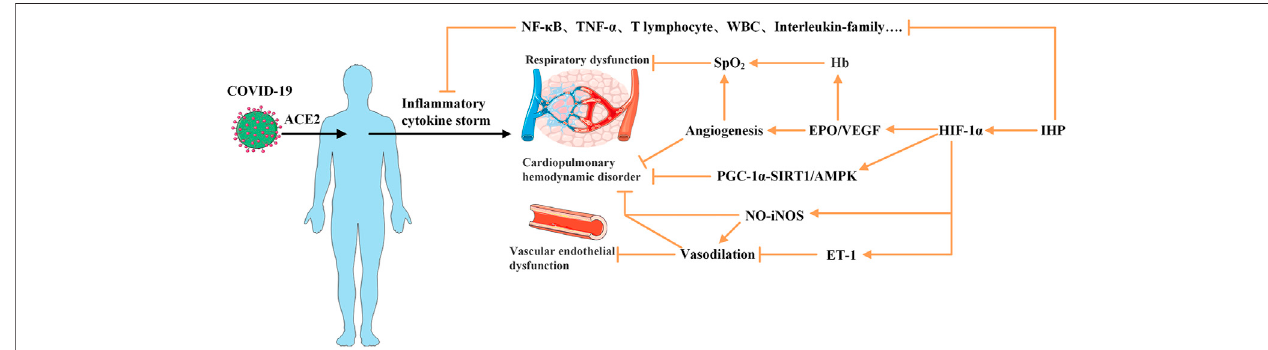
FIGURE1| Plausible mechanisms ofintermittent hypoxia preconditioningapplied for COVID-19 rehabilitation.COVID-19 virusenters thebody and combines with ACE2 to produce an excessive immune reaction and to trigger “ in fl ammatory cytokine storm, ” which may initiate the pathogenesis of SARS, cardiopulmonary hemodynamic disorder and vascular endothelialdysfunction. Applicationof IHP on patientsmay provide inhibitory effect on the levels ofvarious proin fl ammatoryfactors and activate HIF-1 to promote target genes to augment EPO/VEGF expression which lead to stimulate production of red blood cell and Hb and angiogenesis to increasecapacitytocarryoxygen.Furthermore,activatedHIF-1maymobilizePGC-1-SIRT1/AMPKpathwayandNOavailabilityandinhibitET-1.Thesefactorscanhelp reverse the virus induced cardiopulmonary hemodynamic disorder and endothelial dysfunction. ACE2, Angiotensin-converting enzyme 2; AMPK, 5 ’ -AMP activated protein kinase; EPO, erythropoietin; ET, endothelin; Hb, hemoglobin; HIF, hypoxia-inducible factors; PGC, γ -coactivator; NF-B, nuclear factor-k-gene binding; SARS, serveracuterespiratorysyndrome;SIRT,Sirtuin;TNF- α ,TumorNecrosisFactor- α ;VEGF,vascularendothelialgrowthfactor;WBC,whitebloodcell.symbolindicatesan activation; symbol indicates an